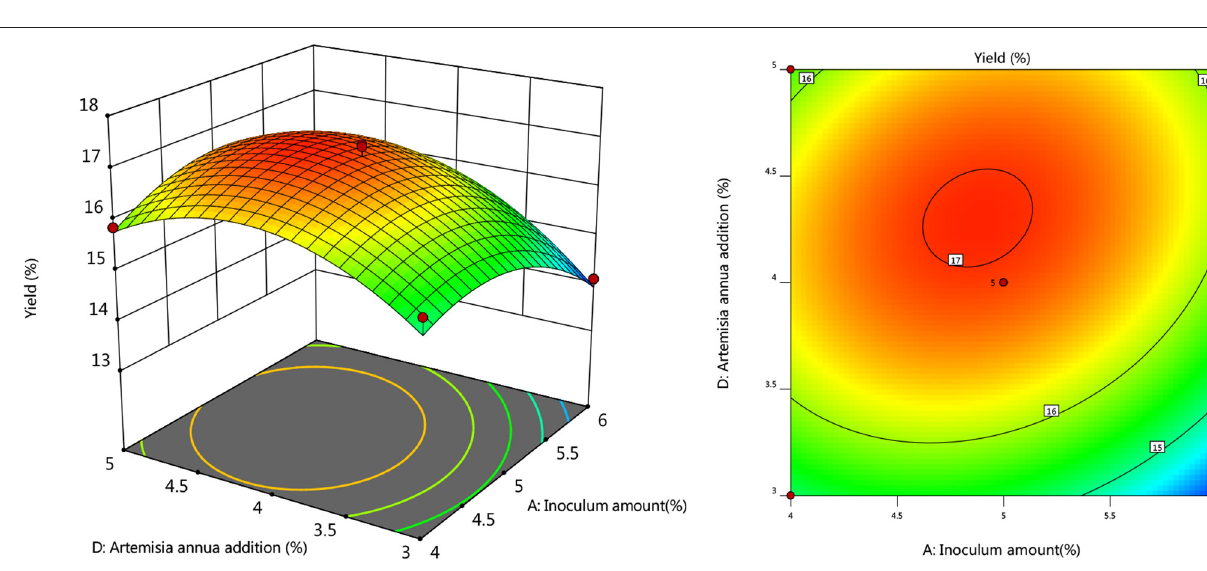
FIGURE 8 | Response plot of the interaction between inoculum and Artemisia annua addition on